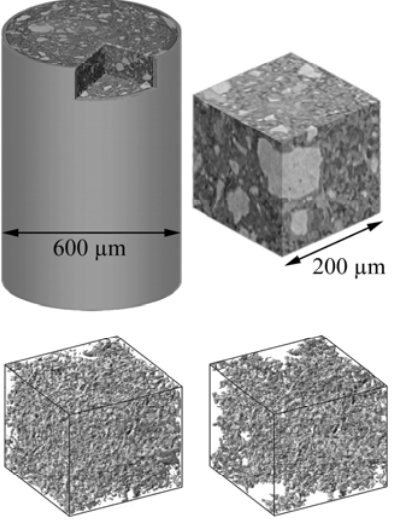
Figure 18. Refractive index microradiology implemented in the tomographic mode: computer-reconstructed images derived from a large number of projection radiographs. The top images (data from Ref. 27) were obtained for a 1 day old cement sample and show a reconstructed rendering of the entire sample as well as that of a specific volume. The bottom images – referring to a 3 day old sample - show how computer processing can yield reconstructed images of the pores (bottom left) and of the fraction of the pores that are interconnected or